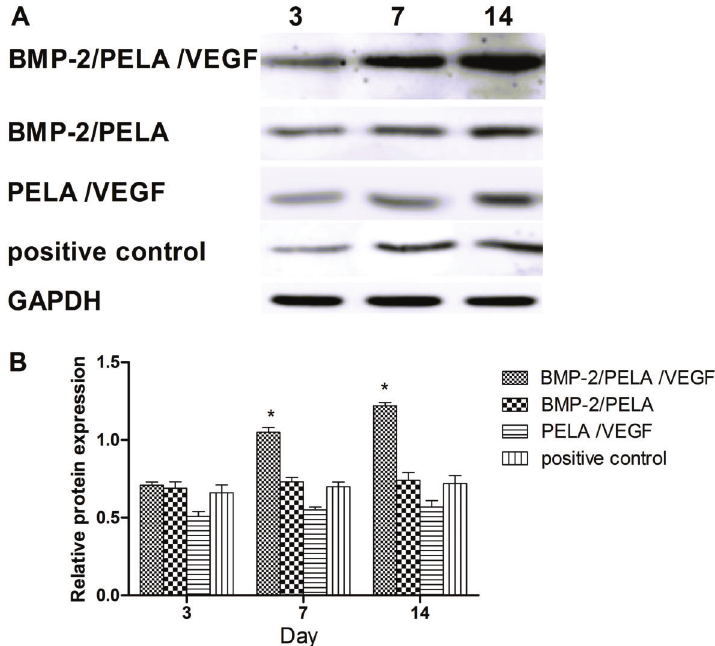
Figure 6. Expression of alkaline phosphatase (ALP) protein in BMP-2/PELA/VEGF and BMP-2/ PELA scaffolds, as well as the positive control, 3, 7, and 14 days after mesenchymal stem cells seeding. A , Western blotting images. B , Quanti- fi cation of ALP based on western blotting anal- ysis. Results are reported as means ± SD (n=5). *P o 0.05, compared to the 3-day group (ANOVA). BMP-2: bone morphogenetic protein-2; PELA: polylactide-poly (ethylene glycol)-polylactide; VEGF: vascular endothelial growth